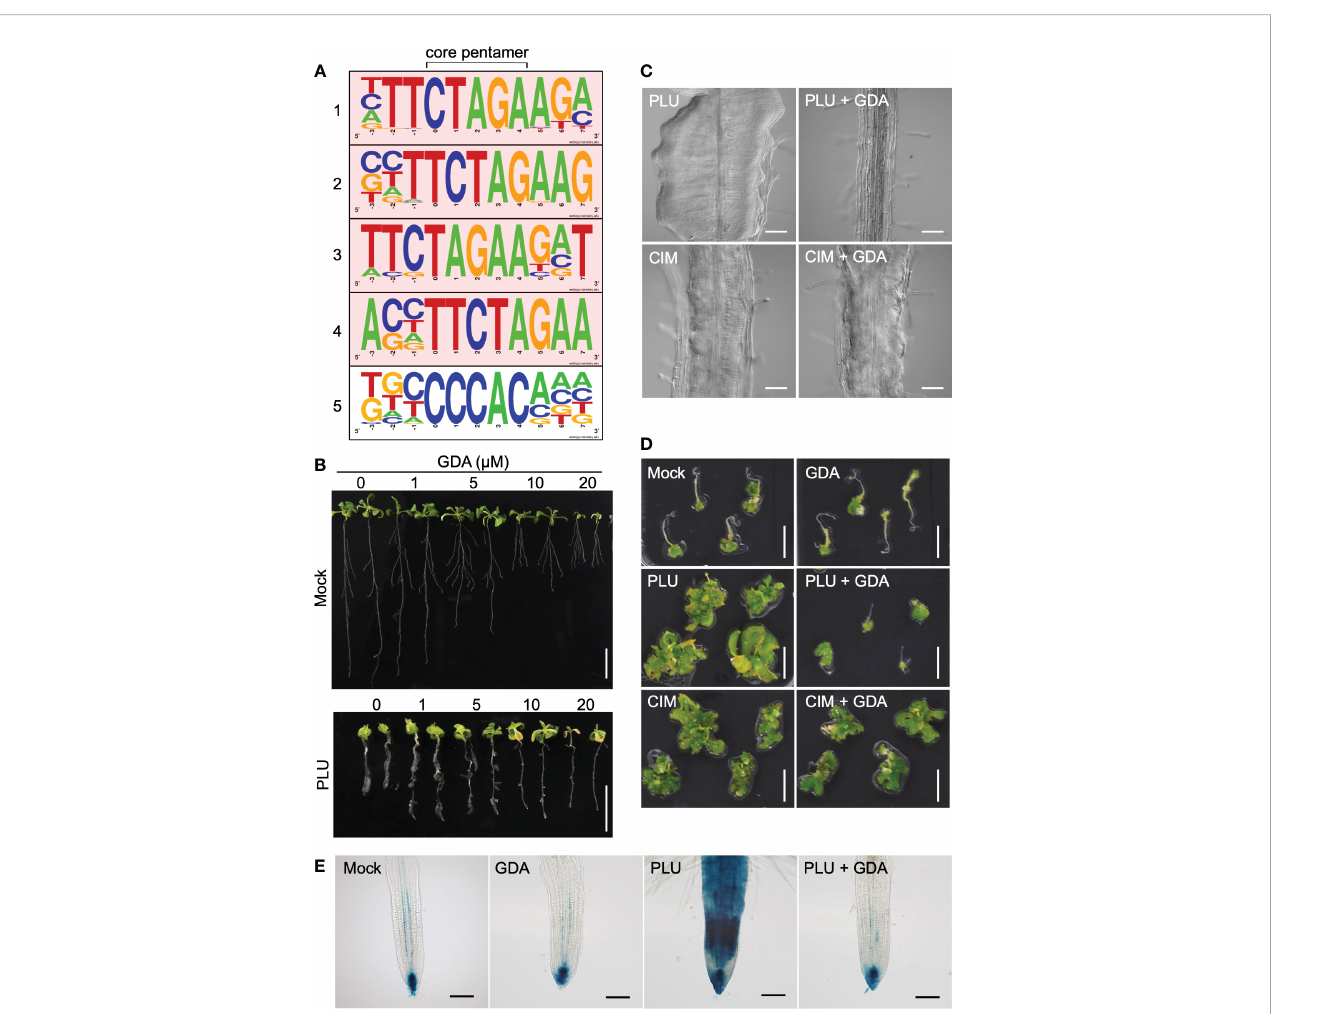
FIGURE 5 PLU requires HSP90 activity to trigger DR5 responses and the callus formation. (A) The top fi ve motifs overrepresented in 1-kb upstream sequences of 292 genes upregulated more than two-fold 1 hour after PLU treatment by a program that identi fi es overrepresented cis elements by comparing surrounding sequences for every pentamer in input sequences. The core pentamer of each overrepresented motif is positioned at the center. The top four motifs containing TTCTAGAA sequences are highlighted in pink. (B) 5-dpi wild-type seedlings were transferred to media containing indicated concentrations of GDA with or without 40 µM PLU, and observed at 14 dpi. Scale bars: 1 cm. (C) DIC images of roots of 12-dpi seedlings. 5-dpi wild-type seedlings grown in normal media were transferred to media containing 40 µM PLU- or CIM with or without 20 µM GDA. Scale bars: 100 µm. (D) Root explants from wild-type seedlings at 5 dpi were cultured on 40 µM PLU- or CIM-containing medium with or without 20 µM GDA for 6 days, transferred to SIM, and observed 22 days after the transfer to SIM. Scale bar: 1 cm. (E) 5-dpi DR5:GUS seedlings were treated with or without 40 µM PLU and/or 20 µM GDA, and GUS staining was performed after 48-hour incubation. Scale bar: 40